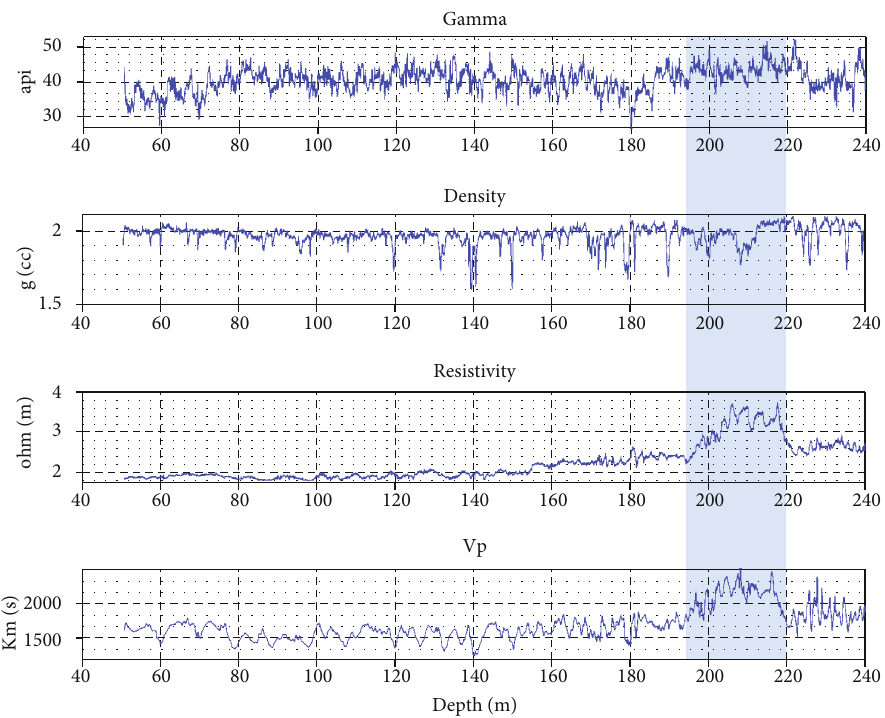
Figure 3: Original curves from well SH2; the blue shaded part indicates the layer of hydrate.